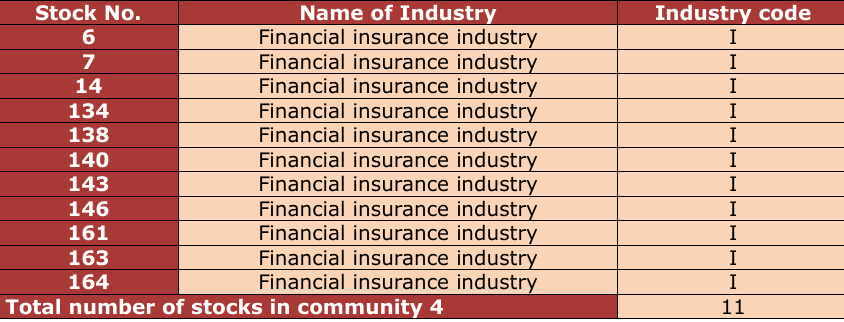
Table 7. Stocks in Community